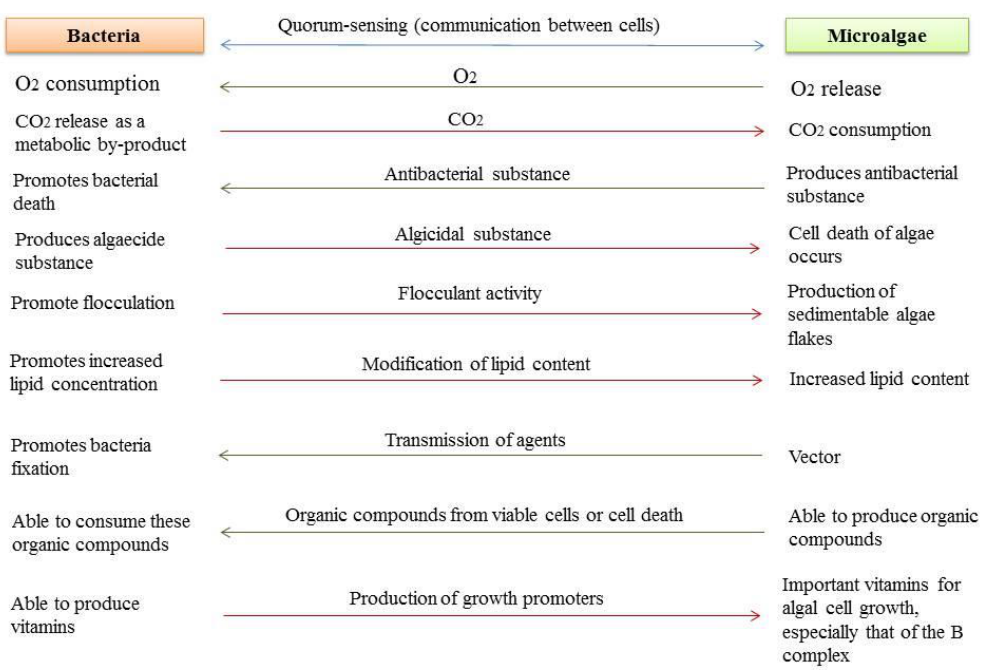
Figure 1. Relationship between bacteria and microalgae indicating its